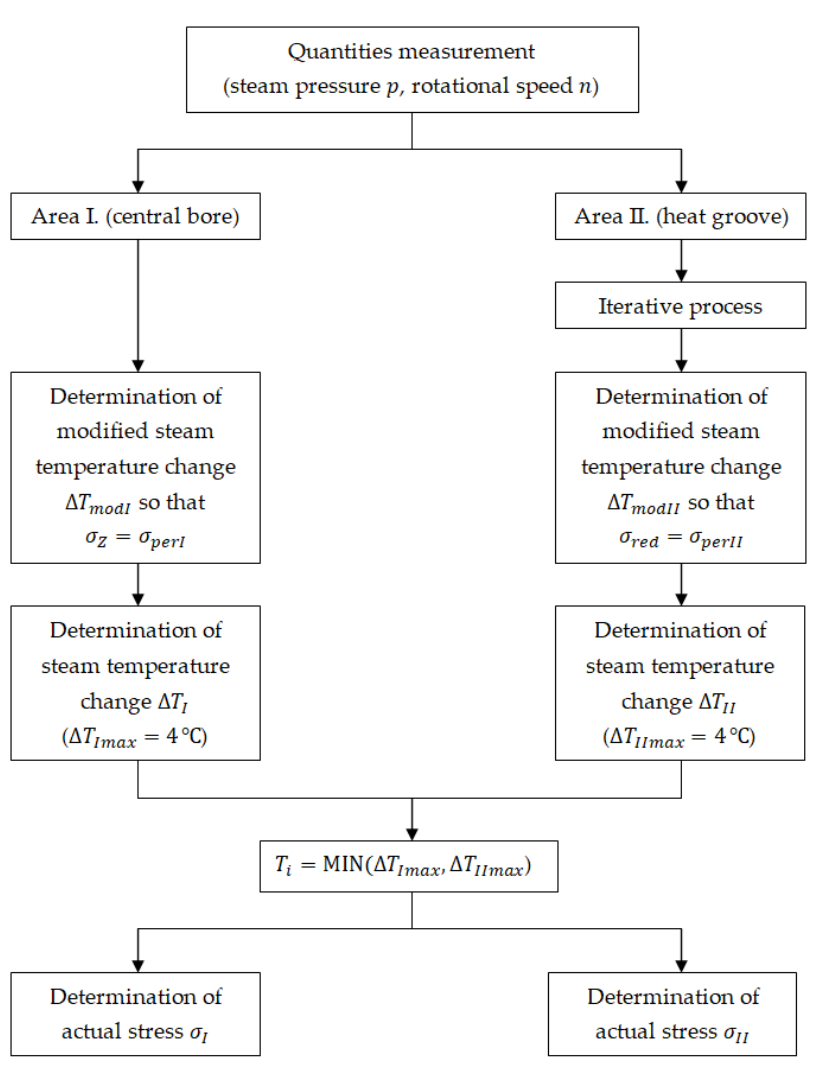
Figure 4. Stress control algorithm for the critical areas of the steam turbine